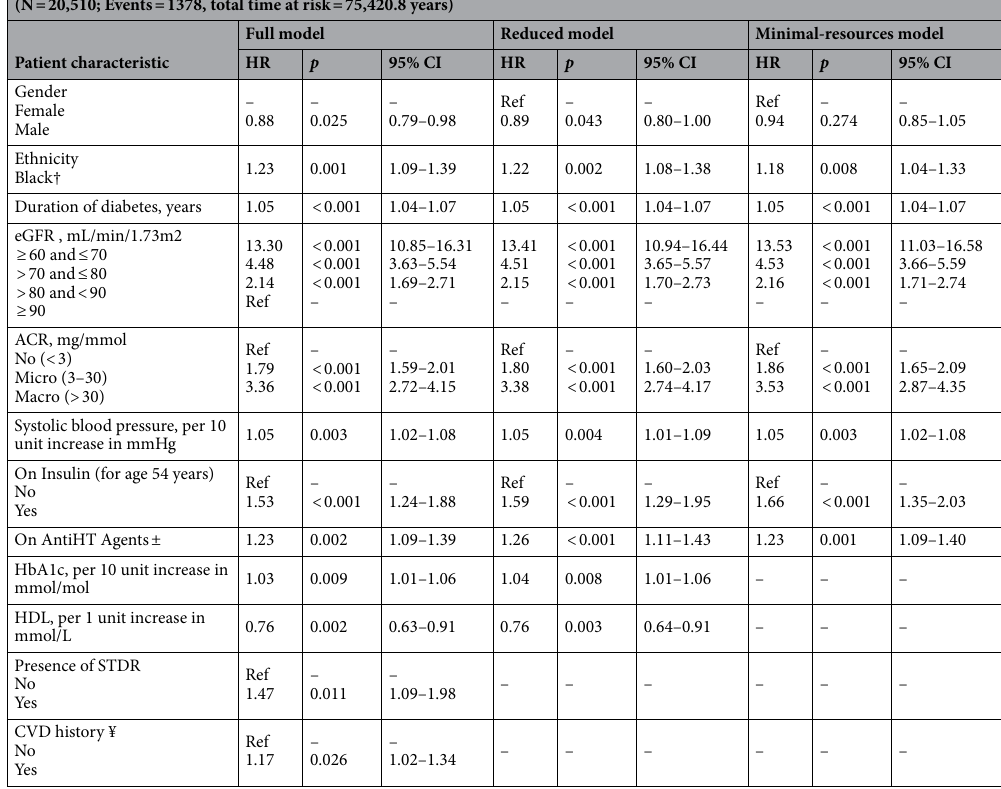
Table 2. Hazard ratios of selected risk factors for predicting 5-year risk of stage 3 CKD in all three resource- driven models. T2D type-2 diabetes; eGFR estimated glomerular filtration rate; Anti‑HT anti-hypertensive; CVD cardiovascular disease; HbA1c haemoglobin A 1c ; STDR sight-threatening diabetic retinopathy; BMI Body Mass Index; HDL High-density Lipoprotein; ACR Albumin: Creatinine ratio. Models included fractional polynomial terms for age and duration as follows: Age term was (age/10)^-0.5–0.43 (centered at age 54 years). Duration term was ln(duration + 0.003)/10 + 1.08. The models also included interaction terms between age and insulin-use for all three models, omitted from the table. The effect of the continuous predictor age by insulin-use is shown in Fig. 1 and the model equations presented in further detail in table S6. ¥CVD includes Myocardial Infarction (MI), stroke, Atrial Fibrillation (AF), Heart failure (HF) ,Coronary Heart Disease (CHD) and Peripheral Vascular Disease (PVD). ± Anti-hypertensive agents include Angiotensin receptor blocker/Angiotensin-converting enzyme (ARB /ACE) drugs. † Compared to patients in the White, South Asian, Mixed or Other